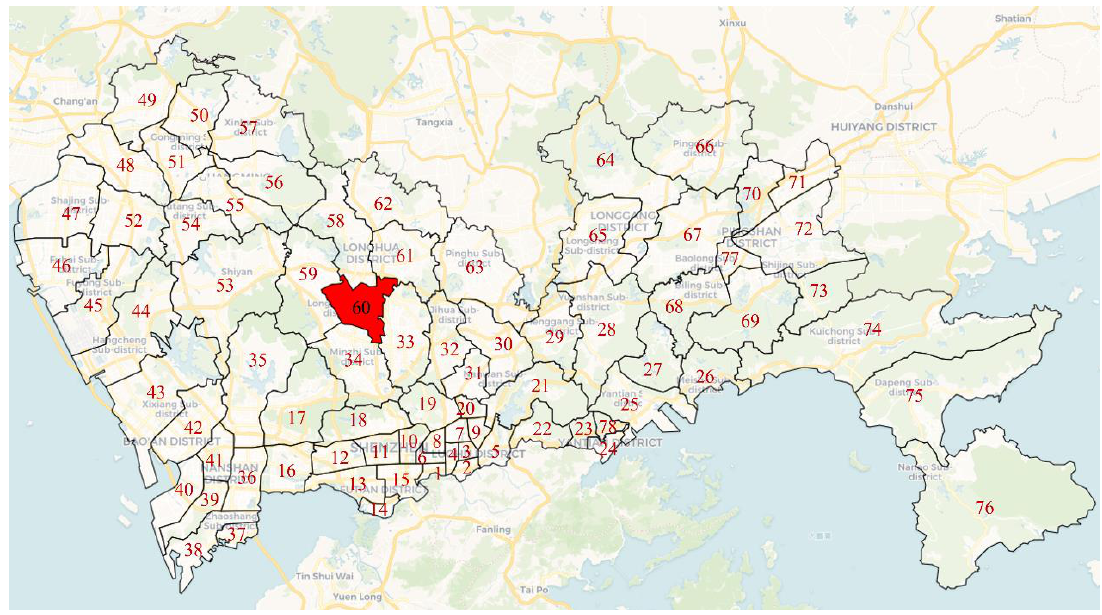
Figure 6. Visualization of 78 divided regions of